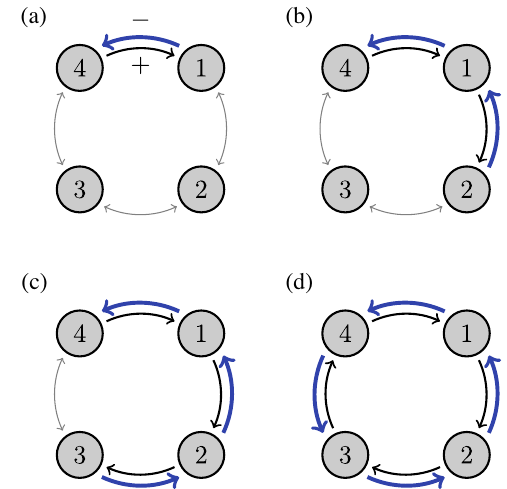
FIG. 4. Illustration of the four possible backbones (thick blue arrows) that ensure the completion of a ( − ) 1 → 4 transition after a (+) 4 → 1 transition, for the example of the four-state Markov model shown in Fig. 3. Thick gray arrows represent the possible transitions, while thick arrows represent the transitions used by trajectories of different lengths. From panels (a) – (d), the trajec- tories have M ¼ 0 to M ¼ 3 . More details are given in the main